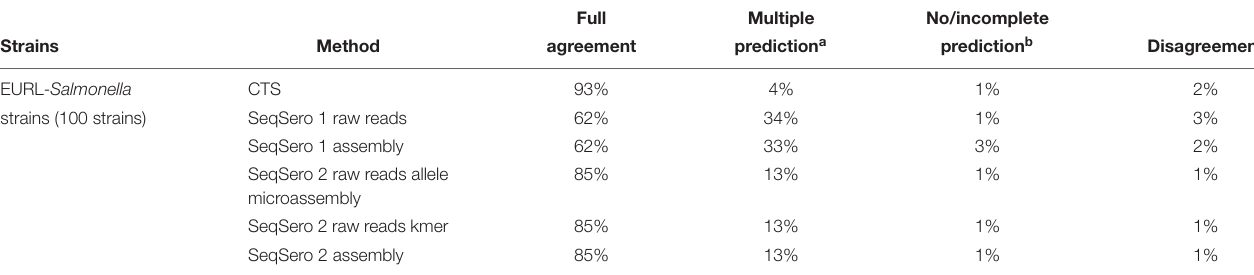
TABLE 2 | Overall results of CTS and SeqSero compared to traditional phenotypic method.